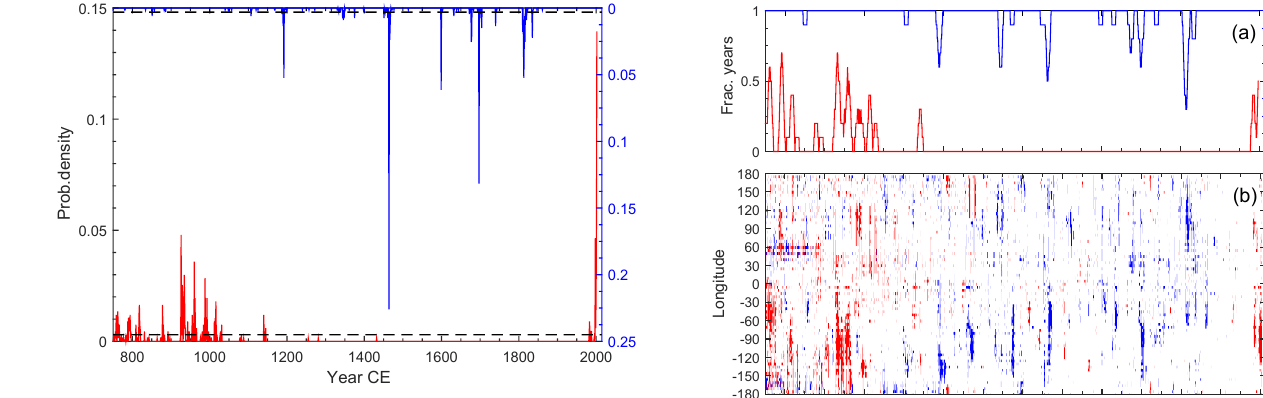
Figure 8. Probability density of statistically significant, poten- tially warmest (red) and coldest (blue) years over the period 750– 2002CE. Dashed lines indicate the 95% significance level esti- mated from the ensemble of bootstrap surrogates.